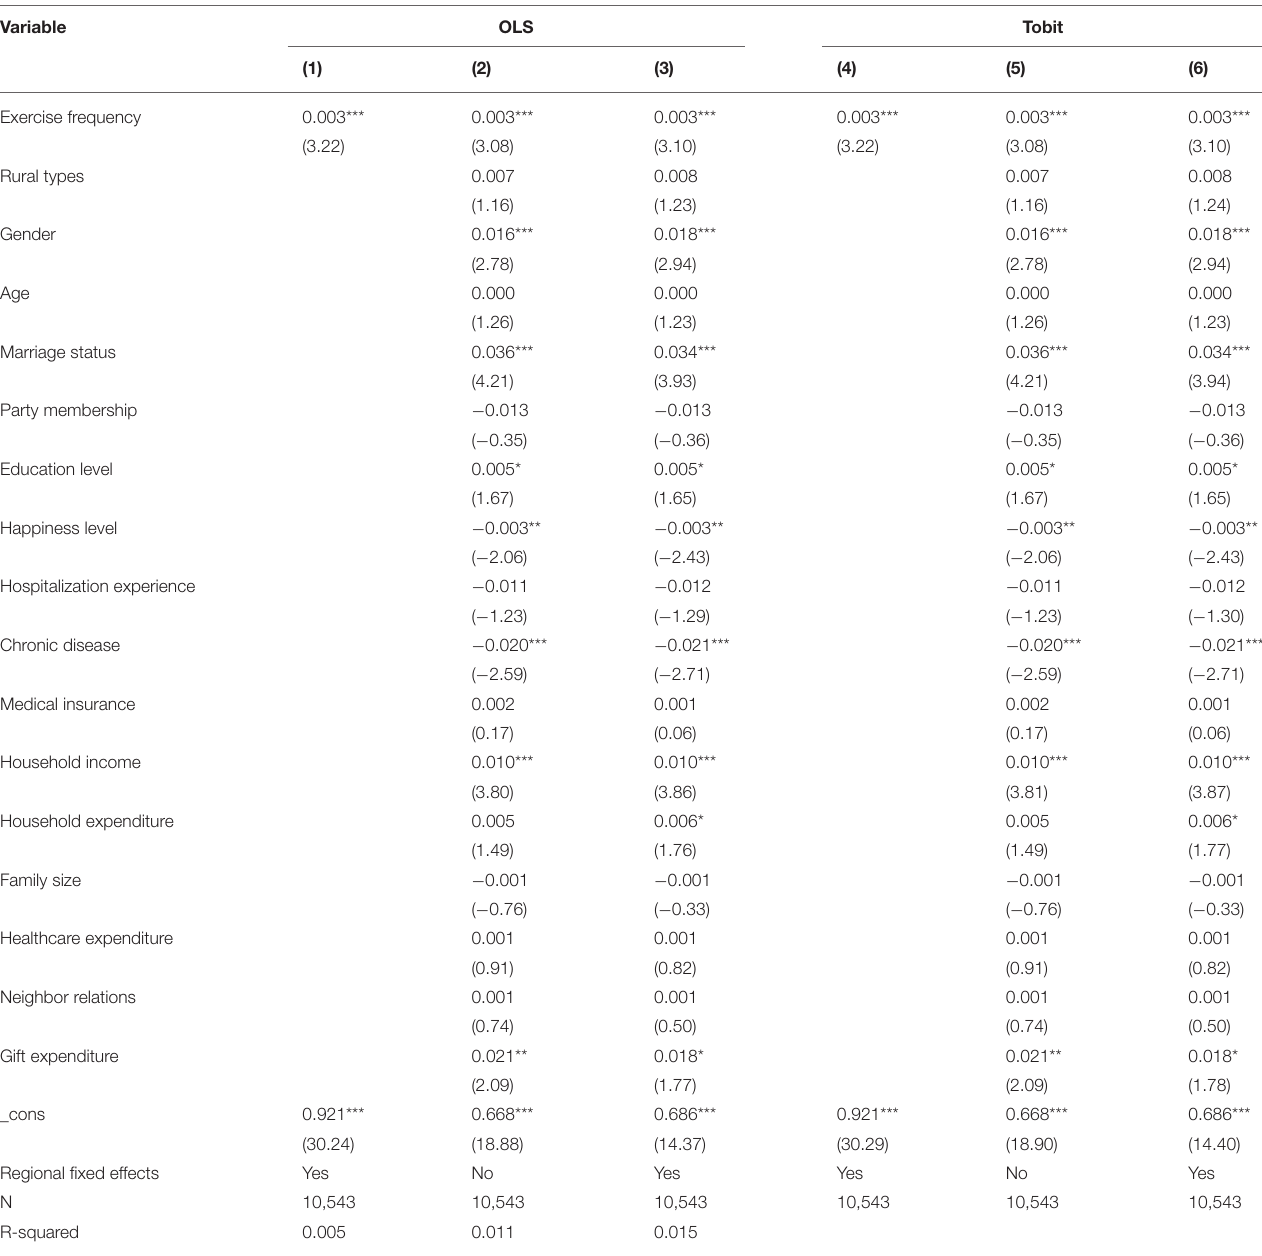
TABLE 5 | Robustness test (replace the explained